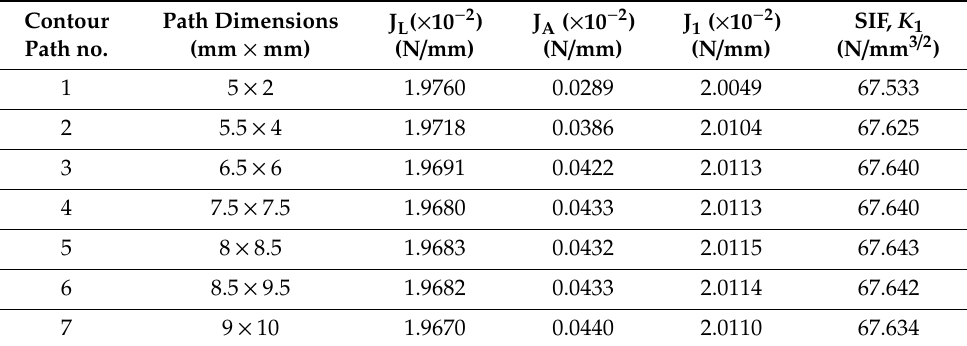
Table 2. Computational SIF values obtained for seven integration paths on the external crack. Contour Path no.